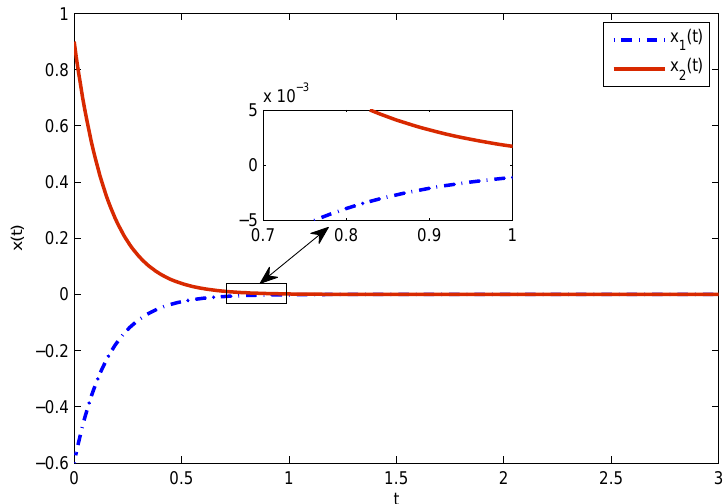
Figure 4. The state trajectories under controllers u 3 ( t ) and u 4 ( t ) . The eigenvalues of the closed-loop system are − 0.7731 and − 0.7732. Under the controllers u 5 ( t ) and u 6 ( t ) , the system state trajectories are shown in Figure 5. As t > 7 ( s ) , | x ( t ) | < 5 × 10 − 3 ( i = 1, 2 ) . i